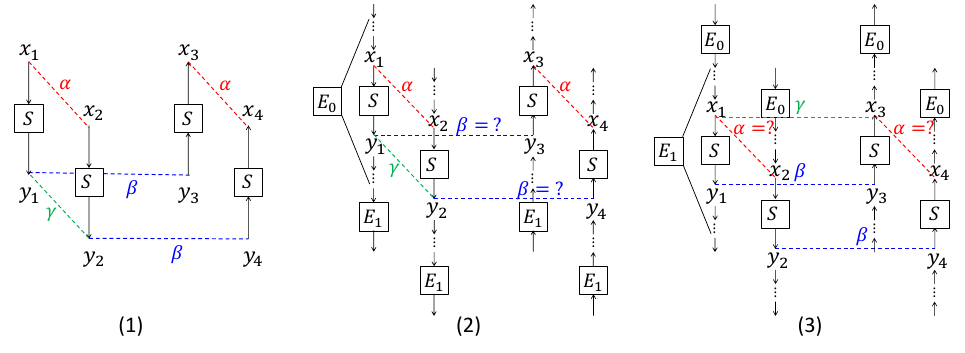
Figure 2: (1) S-box at the connecting point, (2) S-box in E 0 and (3) S-box in E